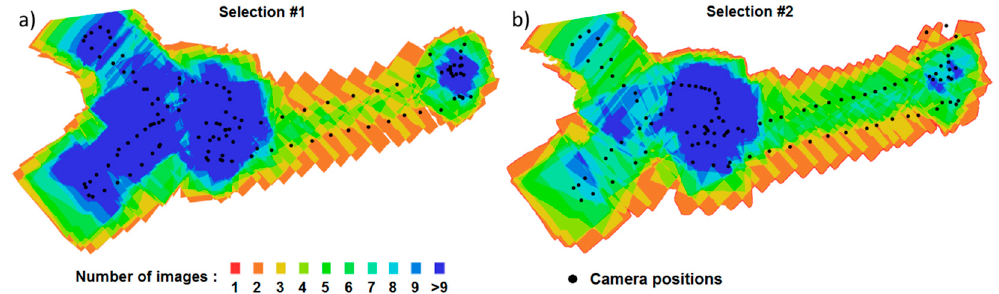
Figure 5. Overlap between images (generated by PhotoScan) with ( a ) an automatic selection of 121 photographs (Selection #1) and ( b ) a manual selection of 109 photographs (Selection #2).